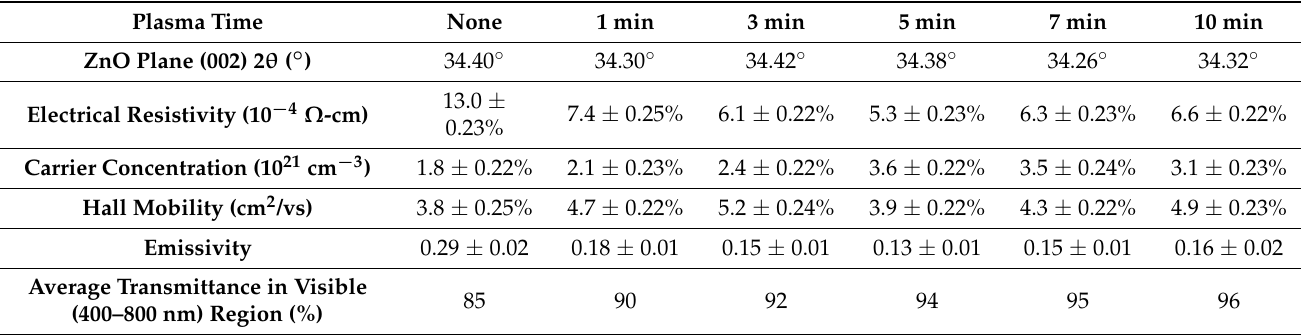
Table 1. Structural, electrical and optical properties and emissivity of the as-deposited and hydrogen- plasma-processed GAZO